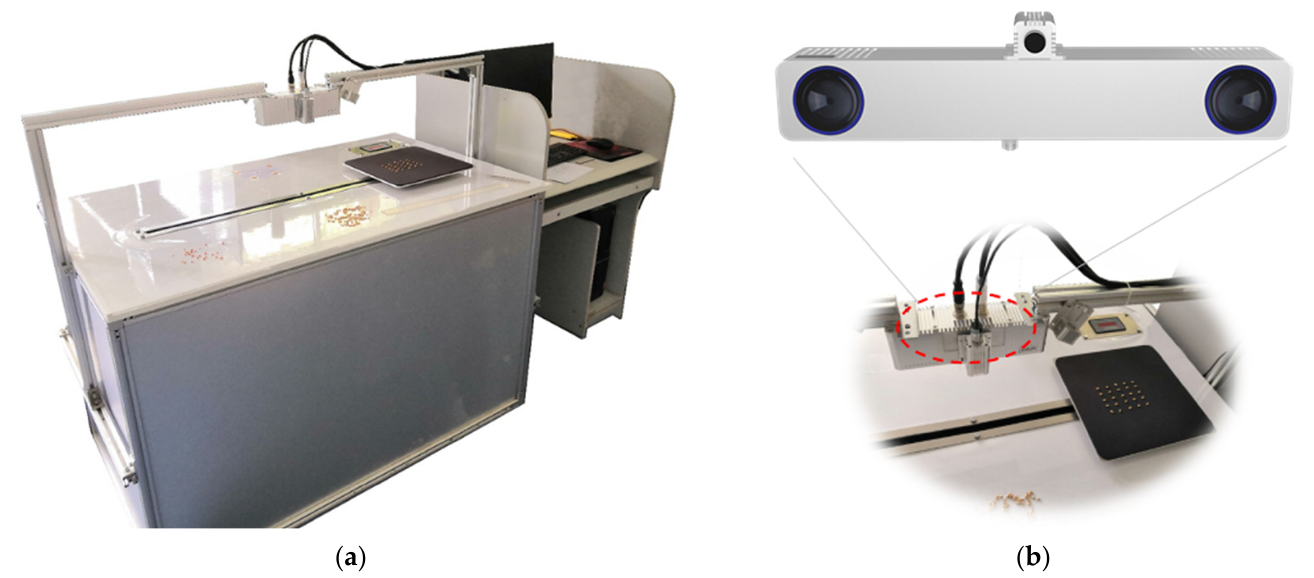
Figure 2. Wheat grain 3D point-cloud acquisition platform. ( a ) Overview of the platform; ( b ) binocular camera.